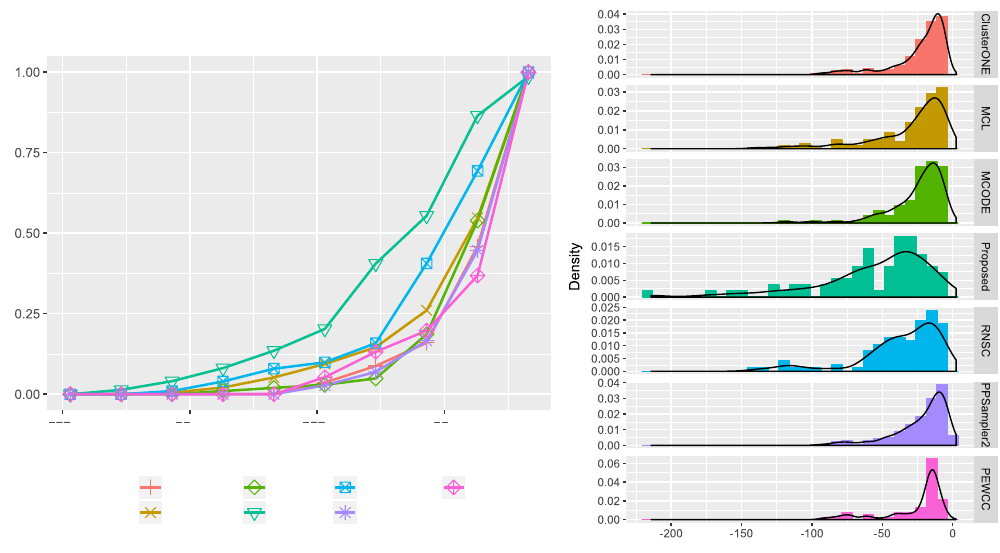
Figure 8. Distribution of p-values of the identified complexes on Gavin data set - ( a ) the left pane shows the fraction of identified modules having p-value below certain value x , ( b ) while the right pane shows the distribution of